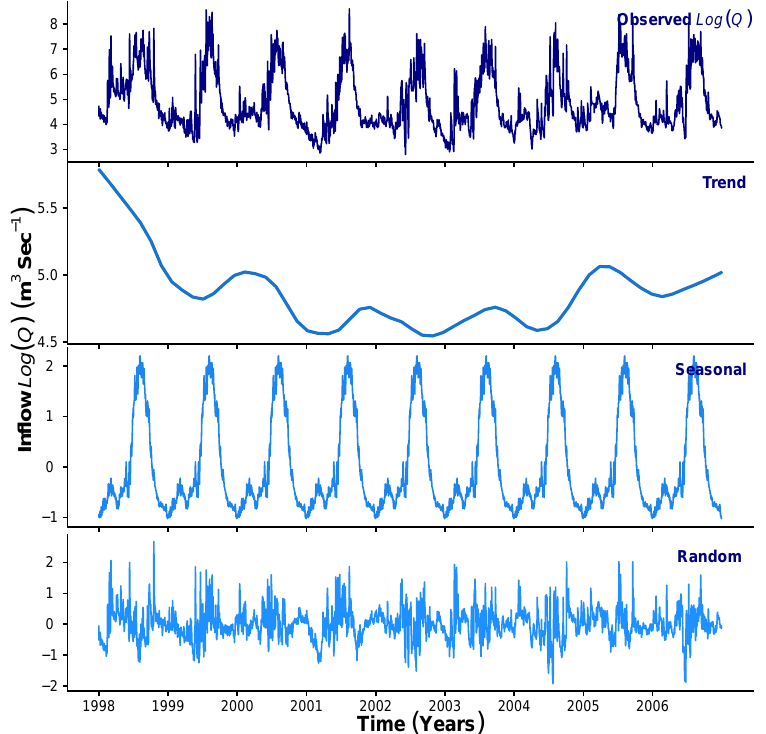
Figure 5. STL decomposition of Log ( Q )